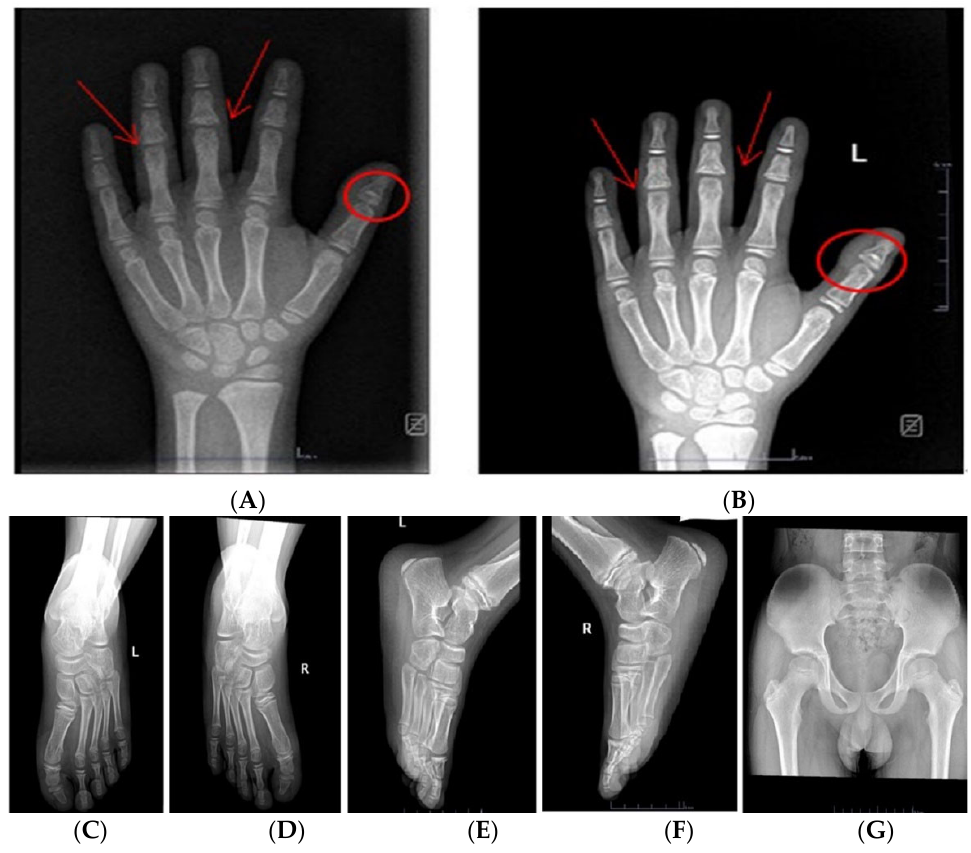
Figure 2. X ‐ ray report of the child: Frontal radiographic findings of the left hands of the child: ( A ): The photograph of the hands shows brachydactylia with shortening of the middle phalanges of all fingers. The coned epiphyses of the first proximal phalanges (circles) and more subtle, partially fused coned epiphyses of the third to fourth middle phalanges (arrows) can be noticed. Bone age